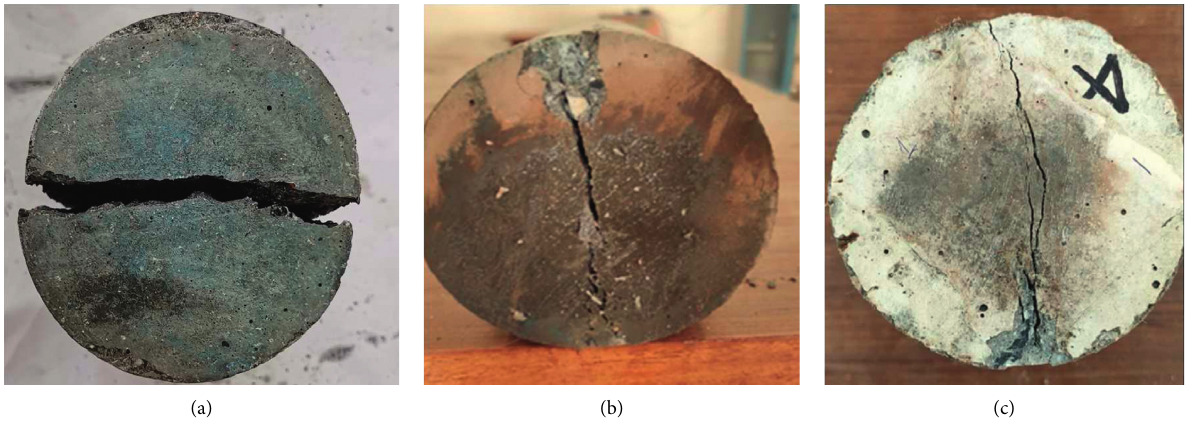
Figure 11: Splitting-tensile failure modes of HSC with (a) 0% WSF, (b) 0.5% WSF, and (c) 1% WSF.